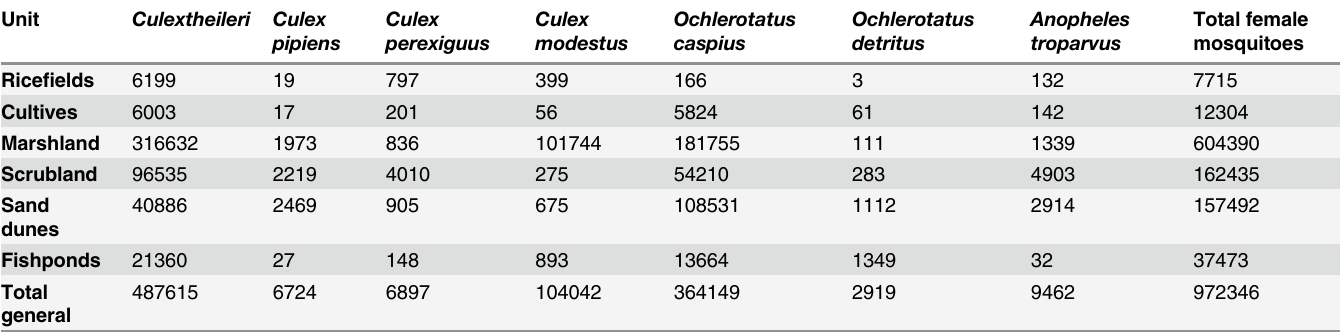
Table 1. Number of female mosquitoes captured in each ecological